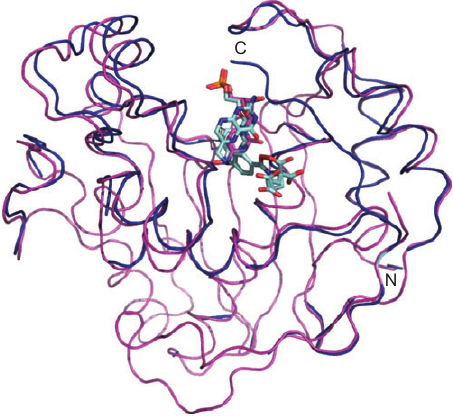
Figure 4 Superimposition of subunits A (the corresponding sub- units in both structures) in the mTS-N 4 -OH-dCMP (pink) and mTS-N 4 - OH-dCMP-DHF (blue) complexes. Ligands, N 4 -OH-dCMP and DHF, are shown as sticks. C- and N-termini of the protein chain are